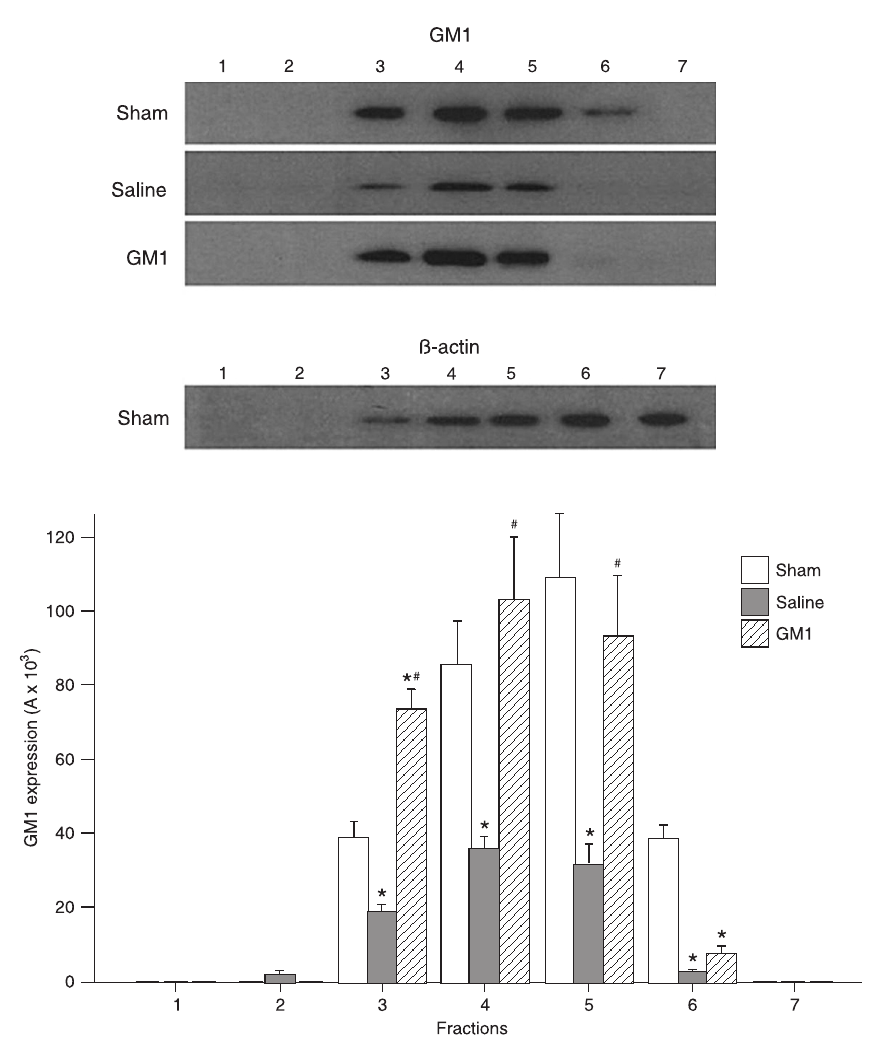
Figure 2. Western blot analysis of monosialotetrahexosyl ganglioside (GM1) in lipid rafts from left cerebral hemispheres of each rat group at postpartum day 30 (P30). The Western blot (lanes 1-7) showed the bands of GM1 in 4 of the 7 fractions prepared by OptiPrep gradient centrifugation. Raft fractions (fractions 3-5) are indicated. A = absorbance. GM1 expression was significantly lower in lipid rafts of the Saline group compared to the Sham group (*P < 0.05), and the expres- sion of GM1 in lipid rafts of the GM1 group was much higher than that in the Saline group ( # P < 0.0.05, one-way analysis of variance (ANOVA) with Bonferroni’s corrections in post hoc